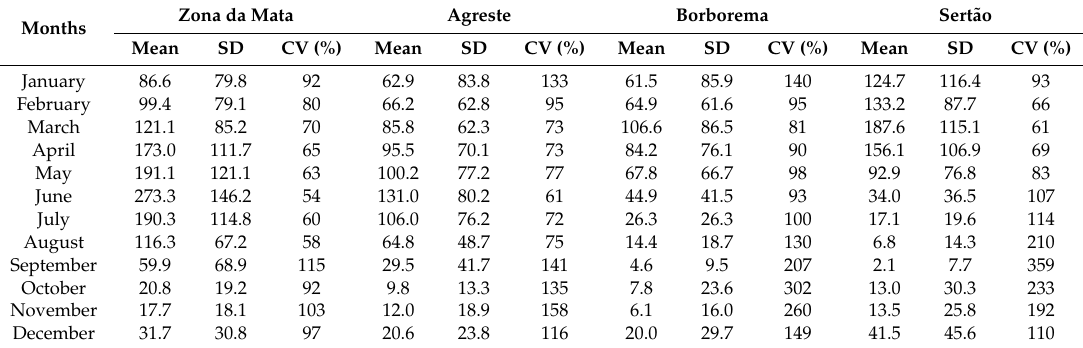
Table 1. Mean values, standard deviation (SD), and coefficient of variation (CV) of rainfall (mm) for